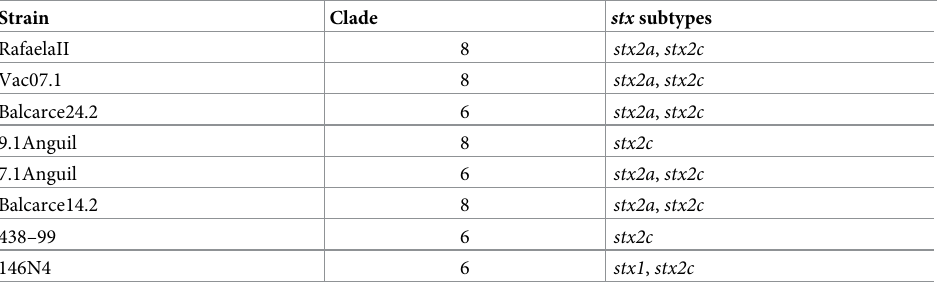
Table 1. Strains with clade assigned and stx